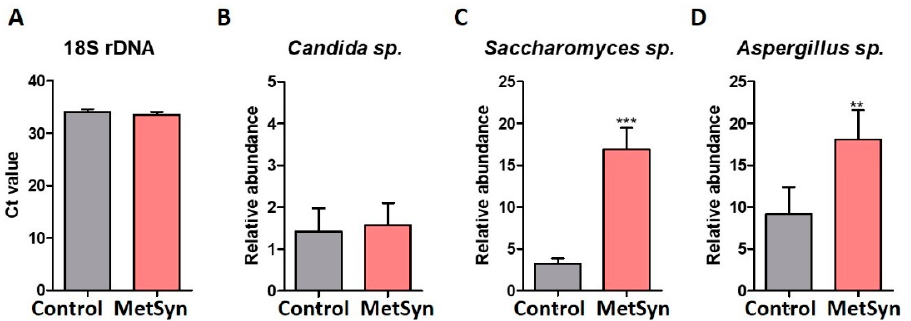
Figure 4. Fungal microbiome in MetSyn: total abundance of fungal 18SrDNA (expressed as Ct values) ( A ). Candida sp. ( B ), Saccharomyces sp. ( C ), Aspergillus sp. ( D ) abundance in fecal samples harvested from healthy individuals and MetSyn patients; Saccharomyces sp.; ** p < 0.01 *** p < 0.0001, Mann–Whitney test.